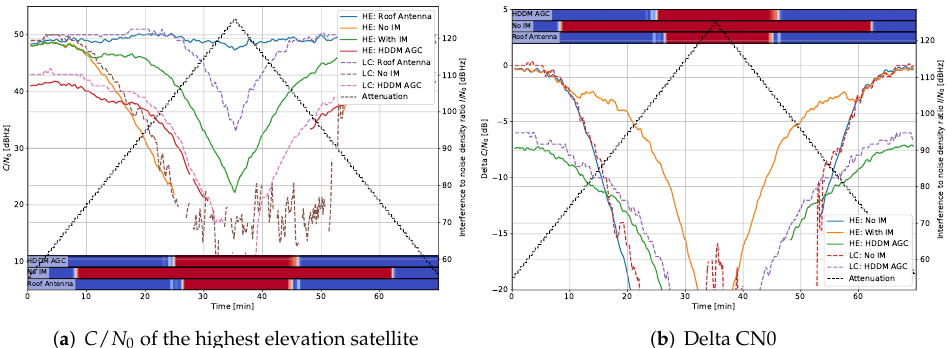
Figure A5. Interference #5: Slow frequency hopper with a dwell time of 100us and a frequency range of 35MHz with GPS L1/CA.